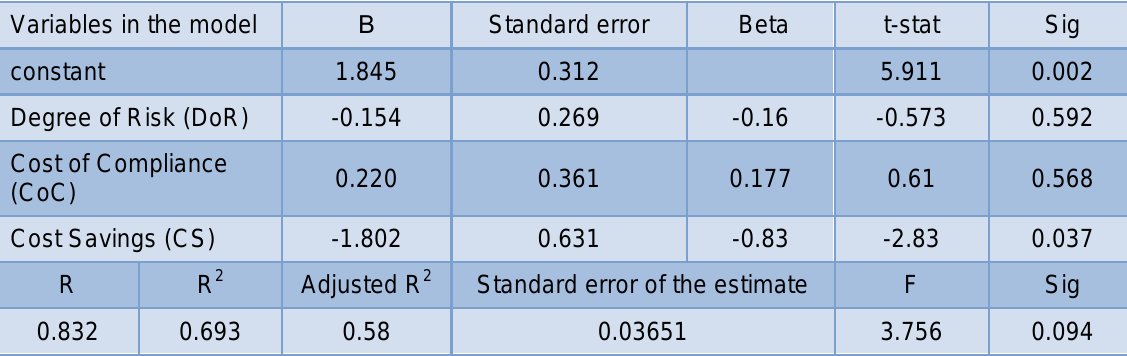
Table 5 Regression analysis results for level of compliance (dependent variable), degree of risk, cost of compliance and